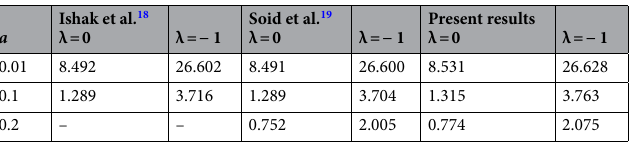
Table 1. Comparison of skin friction along a thin needle with the existing data for different values of a .